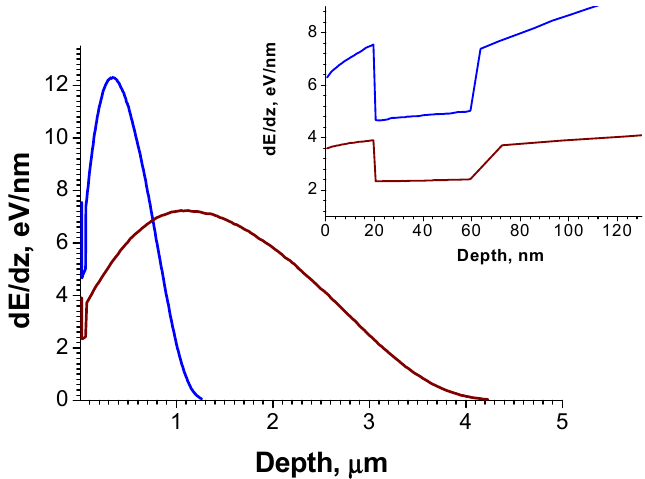
Figure 5. Deposited energy dependence on depth per one primary electron calculated for E b of 10 keV (blue) and 20 keV (wine). The inset shows the deposited energy depth dependencies at a small depth.